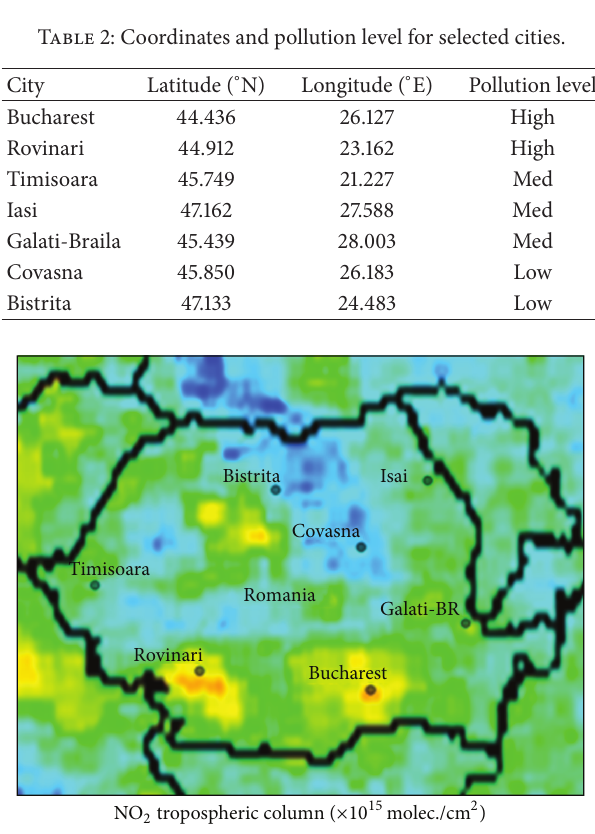
Figure 1: Spatial distribution of the selected cities using a NO 2 OMI map (December